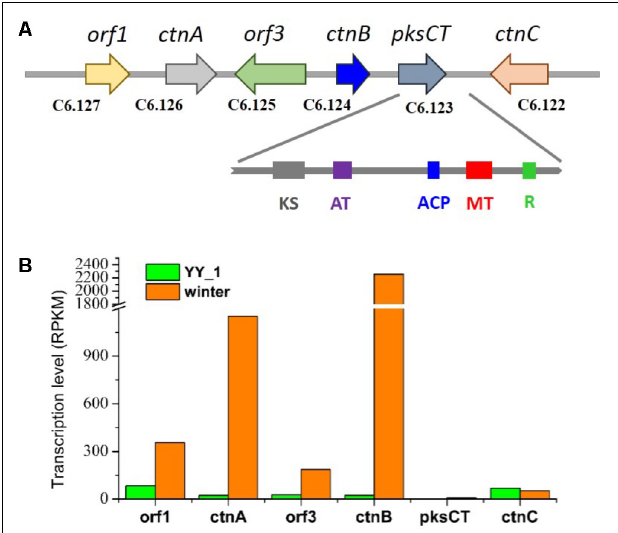
FIGURE 4 | Gene cluster for citrinin synthesis (A) and transcription levels (B) . KS, ketosynthase; AT, acyltransferase; ACP, acyl carrier protein; MT, methyltransferase; R, reductase.